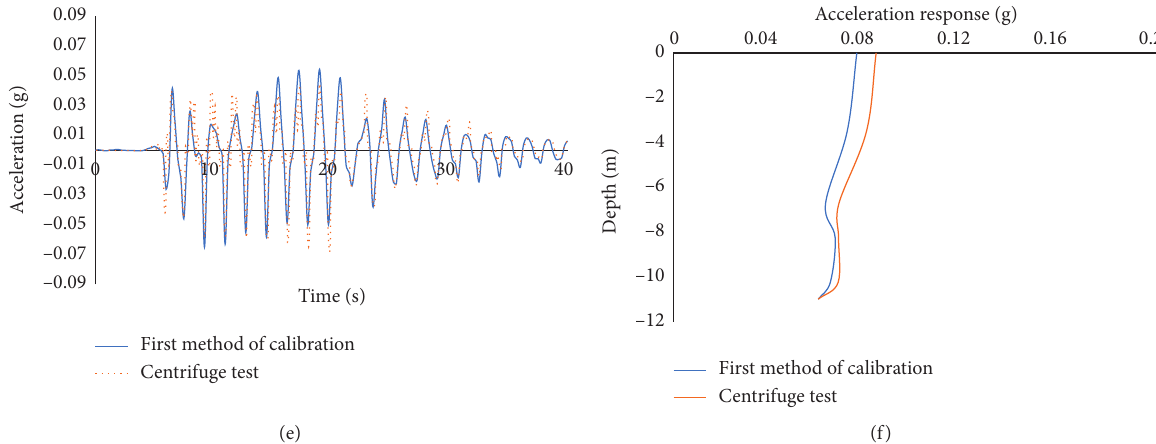
Figure 9: Maximum acceleration response of input motion-1 along the clay: (a) soil surface (numerical results), (b) soil surface (numerical results), (c) soil surface (numerical and the centrifuge results), (d) depth � 6.75m, (e) depth � 10.25m, and (f) soil